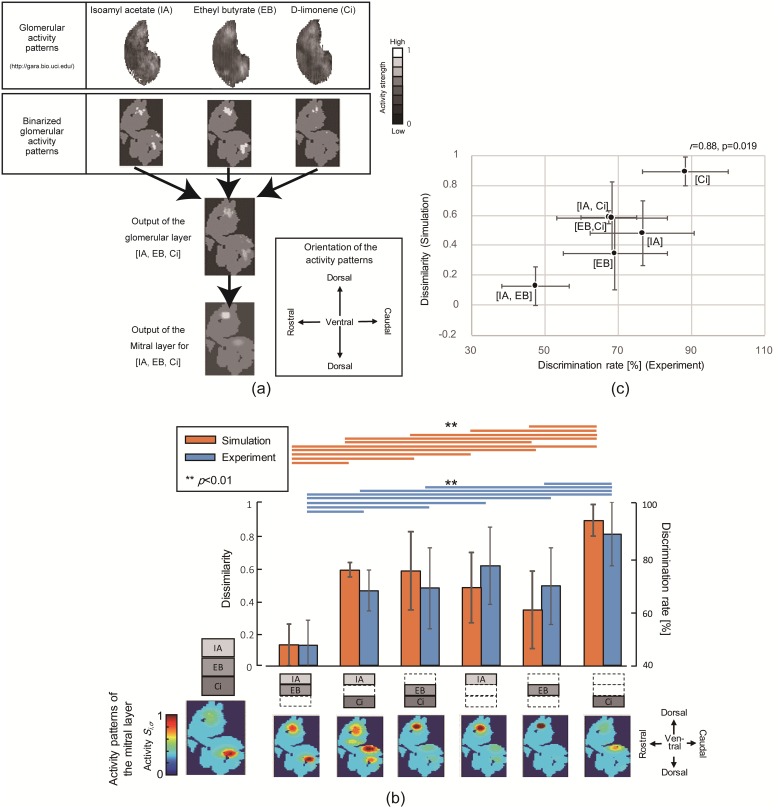
Prediction of perceptual similarity for odors composed of IA, EB, and Ci.(a) Output from the glomerular layer for odorant input [IA, Ci, EB]. The figure shows the steps taken to generate output for the glomerular layer. The activity strength is represented in grayscale, where whiter pixels correspond to higher activity. The uppermost row shows the glomerular activity pattern for the odorant composing odor [IA, EB, Ci] obtained from Johnson et al. [27–31]. The middle row shows the binarized activity patterns given by adapting Eq (2) after dividing the pixels into 1805 lattices and generalizing the activity strength into the range [0, 1]. The third row shows the output from the glomerular layer, and the bottom row shows that from the mitral layer generated by the procedure described in Section 2. (b) Comparison between discrimination rates of mice obtained from experiments and dissimilarity obtained from simulations (ζm = 4, ζg = 15). The figure compares the dissimilarity index E obtained from the simulation and discrimination rate for each odor. The orange bars denote simulation results and the blue bars represent the experimental results. The error bars added to the experimental results address the standard deviation in 10 mice, and the error bars added to the simulation results correspond to the standard deviation of 20 sets of synapse connection parameters. Orange and blue lines above the bars denote a significant difference of p<0.01 between odor pairs. Orange lines represent multiple comparison results from the simulation, and blue lines represent that of experiments on mice. (c) Scatter plot between discrimination rates of mice obtained from experiments and dissimilarity index E obtained from simulations. The figure shows a scatter plot between the dissimilarity index and discrimination rate. The error bars correspond to those in (b).